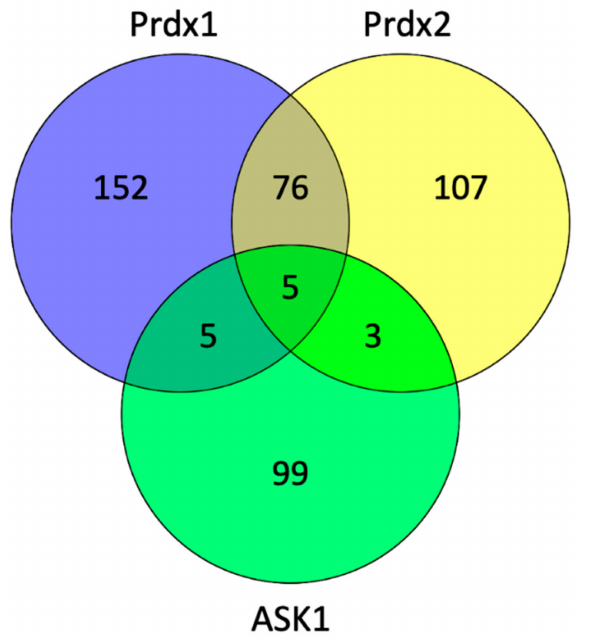
Figure 6. The number of interacting proteins of Prdx1, Prdx2, and ASK1. The diagram was generated by Venny (version 2.1) (https://bioinfogp.cnb.csic.es/tools/venny/, accessed in 30 April 2021) and shows the number of common interactors in the cross sections of the diagram using the data from the PPI database (BioGrid version 4.3.196) (https://thebiogrid.org/, accessed in 30 March 2021) [62].